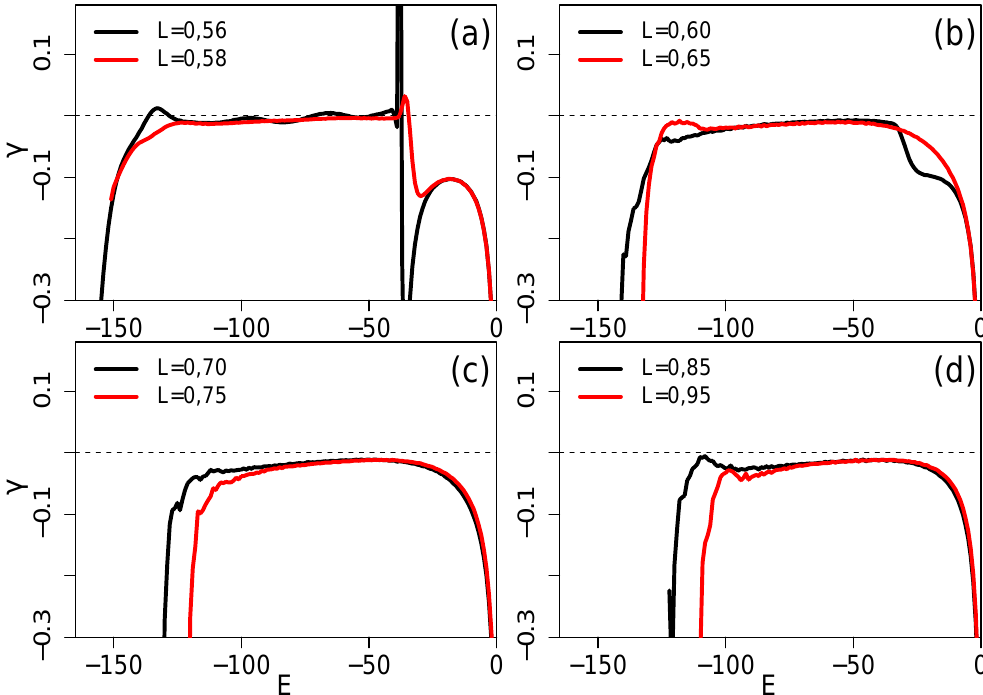
Figure 6. Second derivative of the entropy with respect to energy, γ ( E ) = d 2 S / dE 2 , for different bond lengths in the semi-flexible regime, going from the most flexible chains in ( d ) via increasing stiffness in ( c ) and ( b ) to the border of the stiff regime in ( a ). Peaks with heights above zero indicate a first order phase transition, the others indicate second order